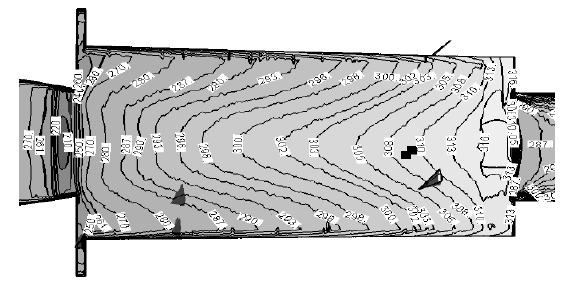
Figure 20. Variation of static temperature at different locations at axial cross section of vortex tube.